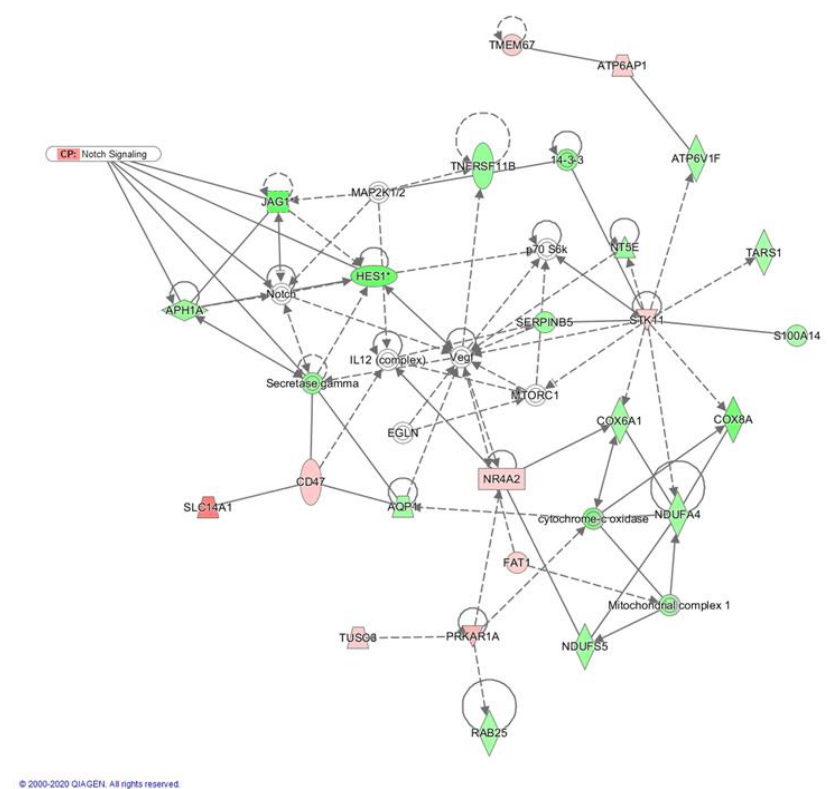
Figure 3. Bioinformatic analysis of networks with ingenuity pathway analysis (IPA). The analysis reports annotated interactions between genes modulated by Crenigacestat treatment in the HuCCT1-xenograft mouse model. The top-ranked network showing a high degree of interconnectivity between genes and the IPA functional category of this network was cancer, cell morphology, and tissue development. The Figure shows that Crenigacestat downregulated key Notch signaling genes, confirming the specificity of the treatment. Up- (red) and down- (green) regulated genes are indicated.